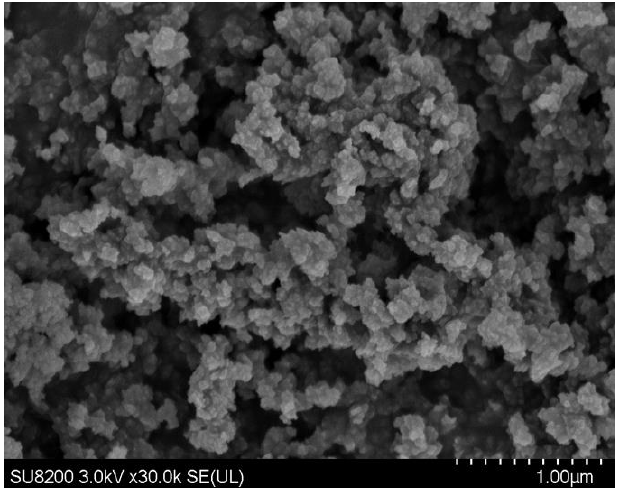
Figure 4. Scanning electron microscopy (SEM) images of 6-EA-β-CD-Si.